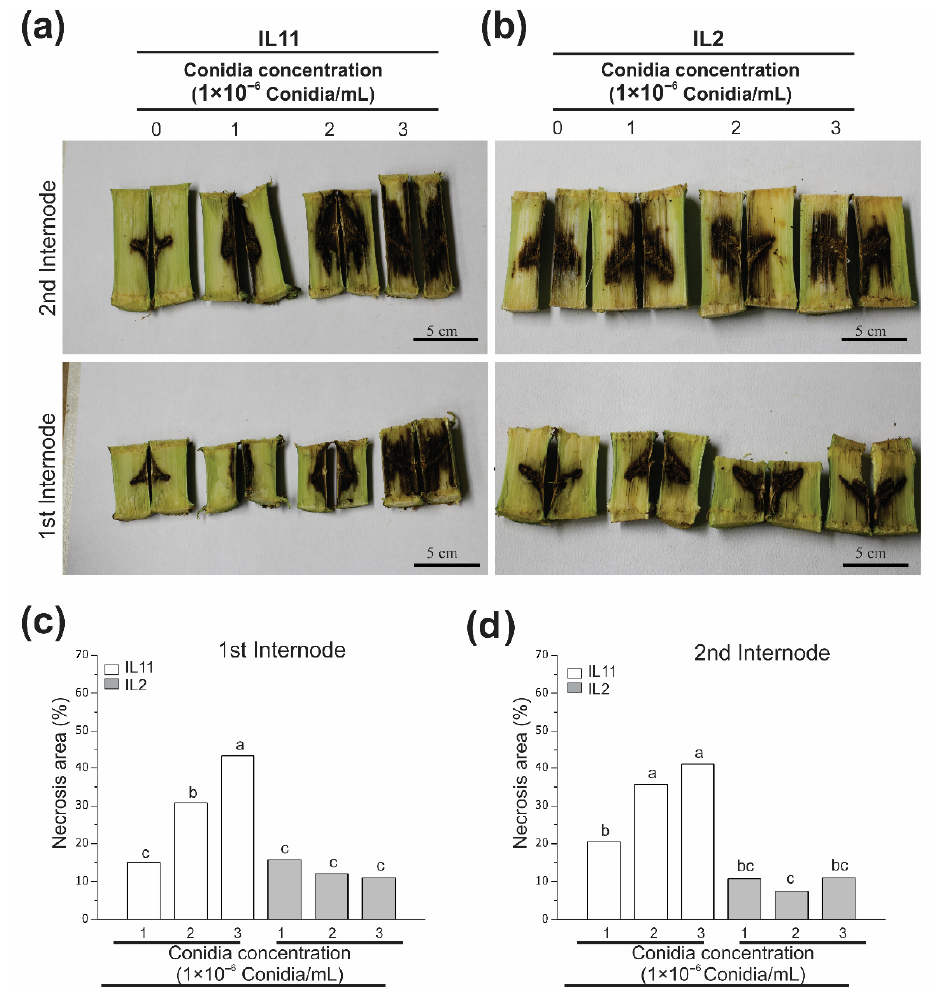
Figure 4. Fusarium effect in stalks at the silking (R1 stage). Necrosis phenotypes for the first and second internodes of the IL11 ( a ) and IL2 lines ( b ). Data were recorded 30 days post-inoculation and were analyzed using ImageJ [48]. The stalk control value was subtracted from the infected stalk values. The graphics show the quantitative necrosis area of each genotype in the ( c ) first and ( d ) second internodes caused by the infection. The different letters above the bars refer to significant differences using the Duncan mean test ( α = 0.01; n = 10). The experiments were performed three times with a completely randomized design.